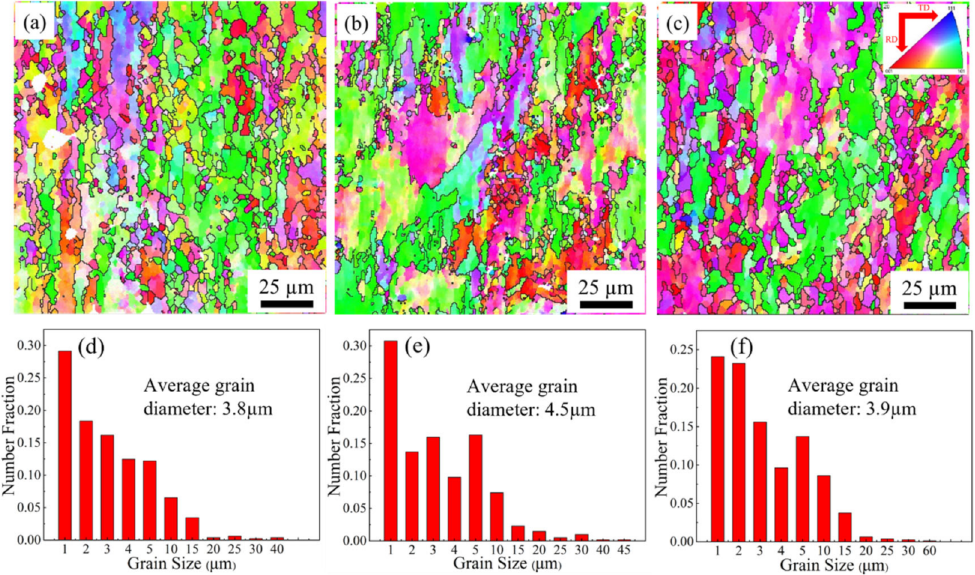
Figure 4. IPF diagrams and corresponding grain size distributions of samples at different rolling temperatures after aging treatment: S420 ( a , d ), S450 ( b , e ), S480 ( c , f ).